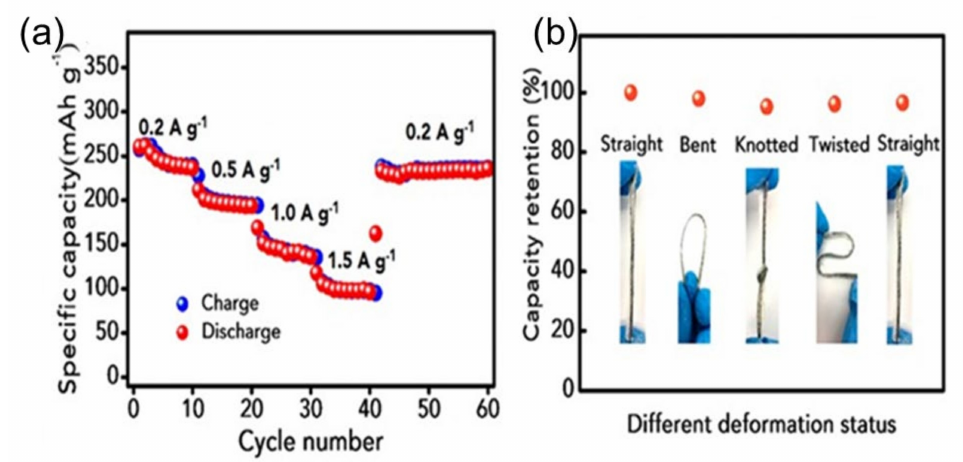
Figure 11. Electrochemical performance of the rechargeable yarn ZIB. ( a ) Rate capabilities at various current densities. ( b ) The capacity retention of the yarn ZIB under various deformation statuses. Reprinted with permission from Ref. [76]. Copyright 2018 American Chemical Society.